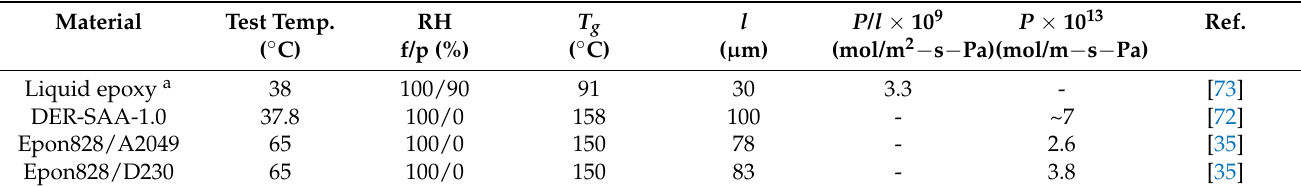
Table 2. Water vapor permeance ( P/l ) and permeability ( P ) data from cup methods. Material Test Temp.